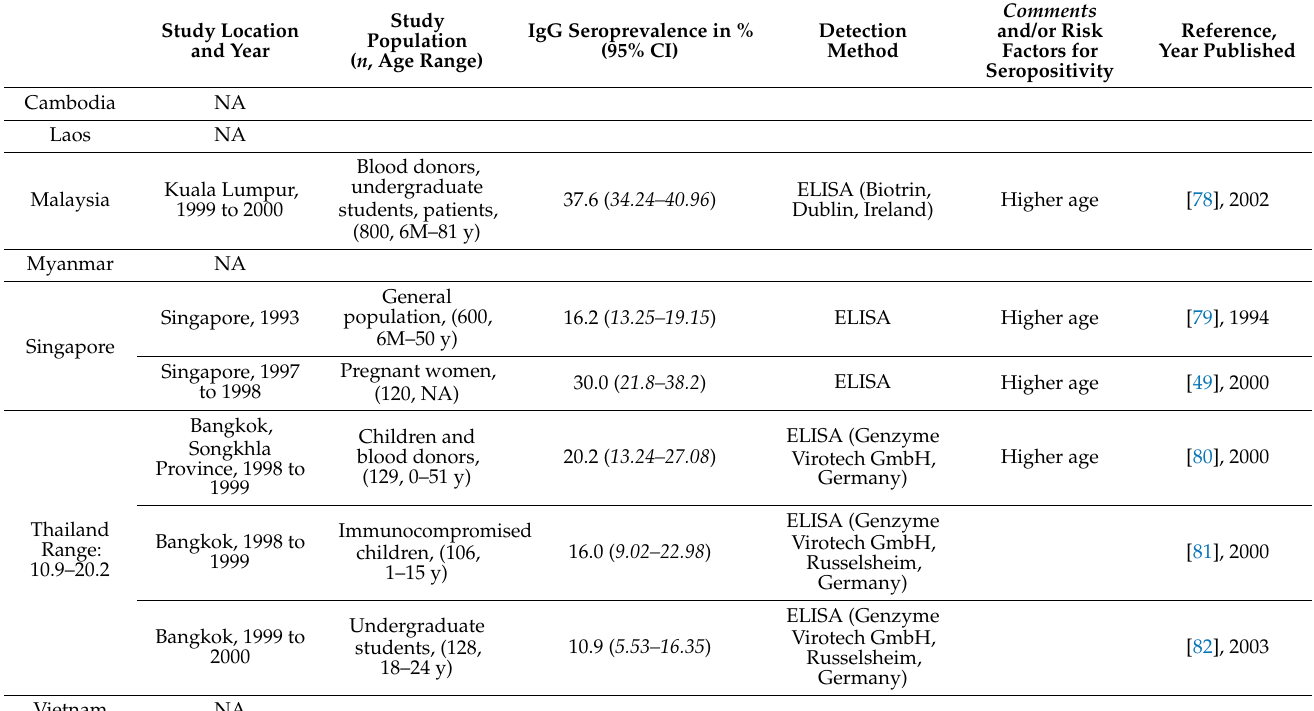
Table 4. Primate erythroparvovirus 1 IgG serosurveys. Confidence Intervals (CI) in Italics estimated as described in Methods; ELISA = Enzyme-linked Immunosorbent Assay; NA = not available; y = years. Comments Study Detection and/or Risk Study Location IgG Seroprevalence in % Reference, Population Method Factors for and Year (95% CI) Year ( n , Age Range) Seropositivity